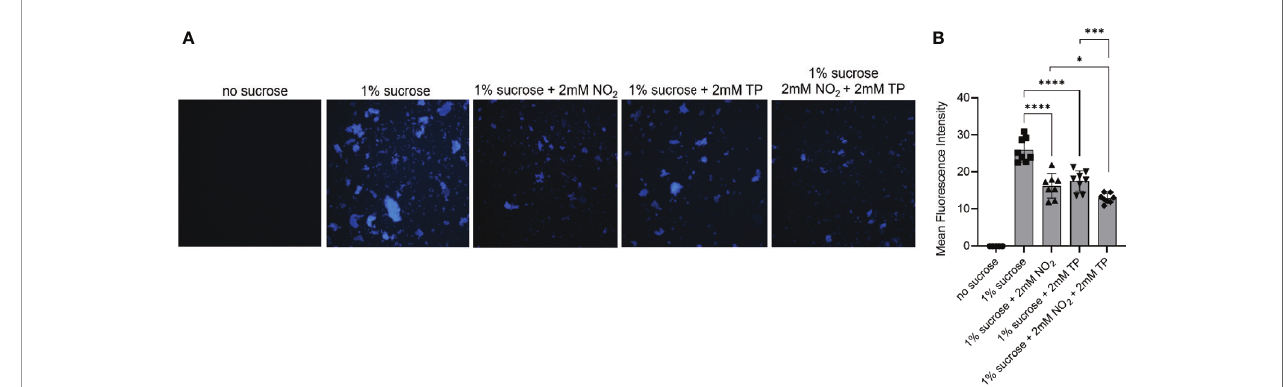
FIGURE 4 | Nitrite and thioproline inhibit S. mutans glucosyltransferase activity. Fluorescence microscopy of puri fi ed GTFs from S. mutans cultures and cascade blue-labeled dextran in (A) TSBYE (no sucrose), TSBYE+1% sucrose, TSBYE+1% sucrose with 2mM NO 2 , 2mM thioproline (TP), or TSBYE+1% sucrose with 2mM NO 2 and 2mM TP. (B) Fluorescence intensity of glucan production. *p < 0.05, ***p < 0.001, and ****p < 0.0001. (Student ’ s t-test). Data are representative of four biological